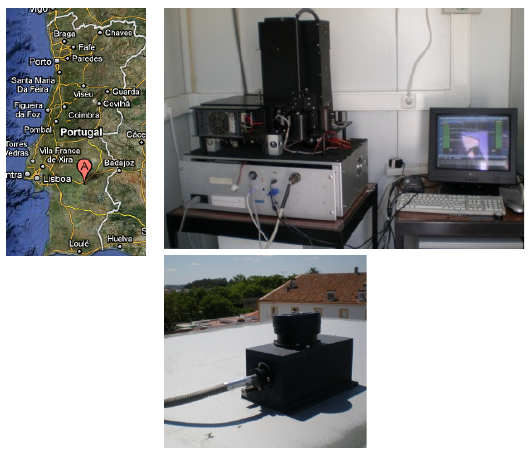
Figure 1. a) The location of Évora city in mainland Portugal. b) Geophysics Centre of Évora (38.5ºN;7.9ºW, 300 m a.s.l.).